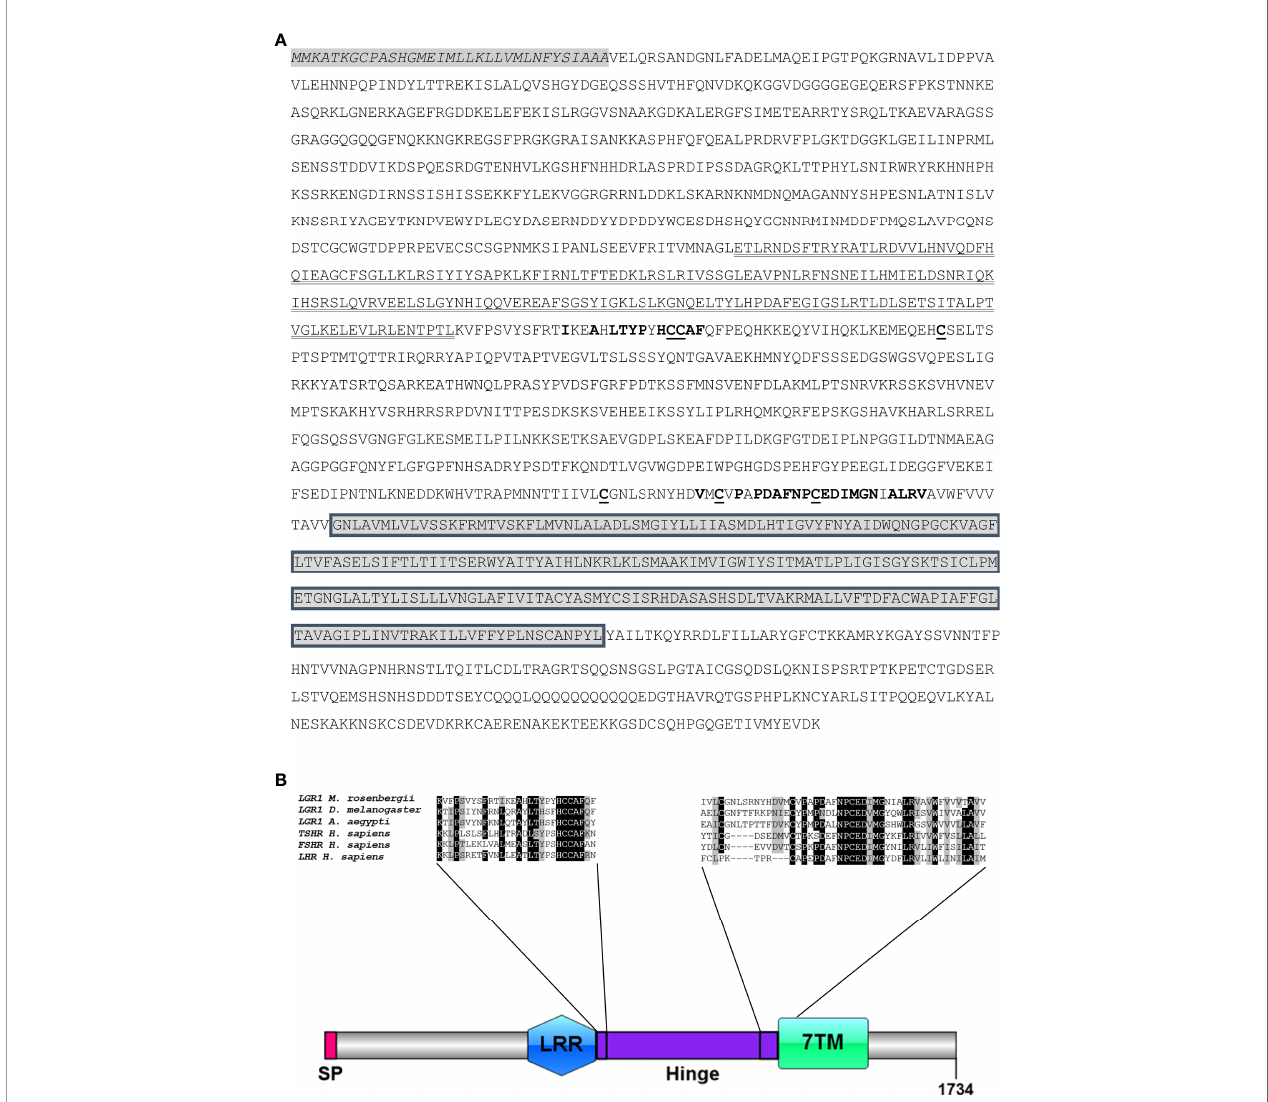
FIGURE 2 | MrLGR1 open reading frame. (A) Deduced amino acid sequence of MrLGR1 and predicted domain sites. Beginning at the N terminus; signal peptide (italicized, gray background), leucine rich repeat domain (bold), hinge region consensus sequences (red and bold), six cysteines in the hinge region (underlined), and the trans-membrane domain (gray boxes). (B) Scaled illustration of MrLGR1 conserved domains, including: signal peptide (SP), leucine-rich repeats (LRR), hinge region (Hinge) and the 7 transmembrane helices (7TM). Multiple sequence alignment of the hinge region of MrLGR1, insect LGR1 and the H. sapiens glycoprotein receptors presents the consensus sequences at the beginning and the end of the